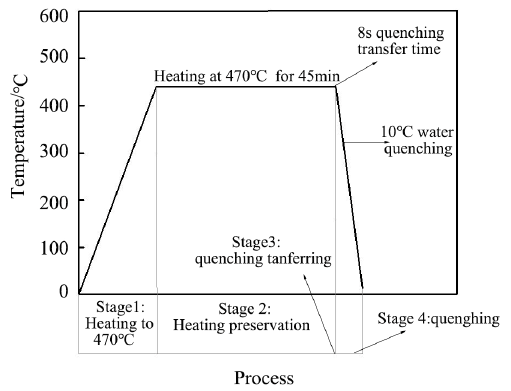
Figure 1. Schematic curve of solution heat treatment and water quenching process.